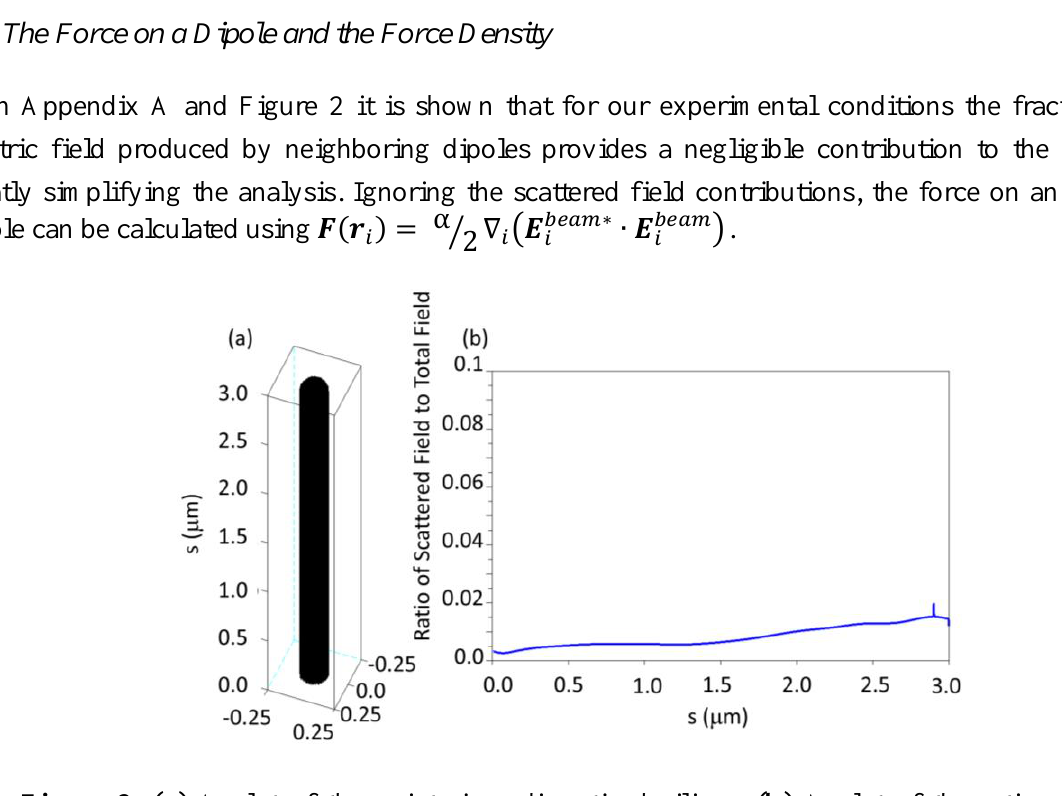
Figure 2. ( a ) A plot of the points in a discretized cilium; ( b ) A plot of the ratio of the scattered electric field in the y direction from the other dipoles to the total electric field in the y direction as a function of s (microns) along the length of the cilium for (δx, δy, δz) = (0 µm, 0 µm, 1.5 µm). Notice that the field from the other dipoles is never more than 3/100 of the total